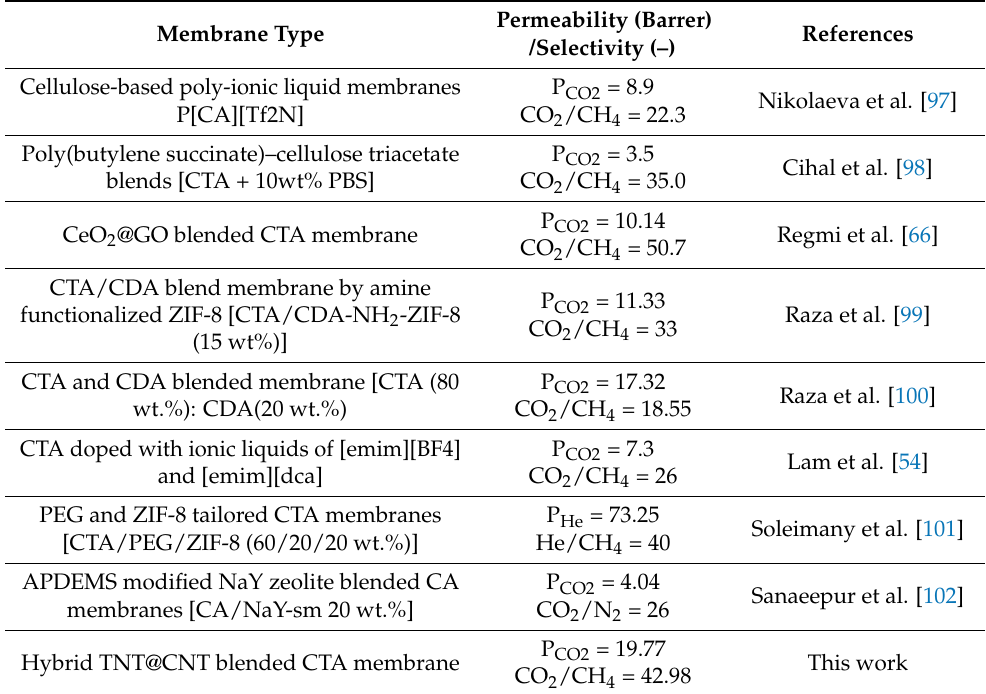
Table 3. Gas sorption performance of the reported cellulose acetate-based MMMs in comparison to this study.